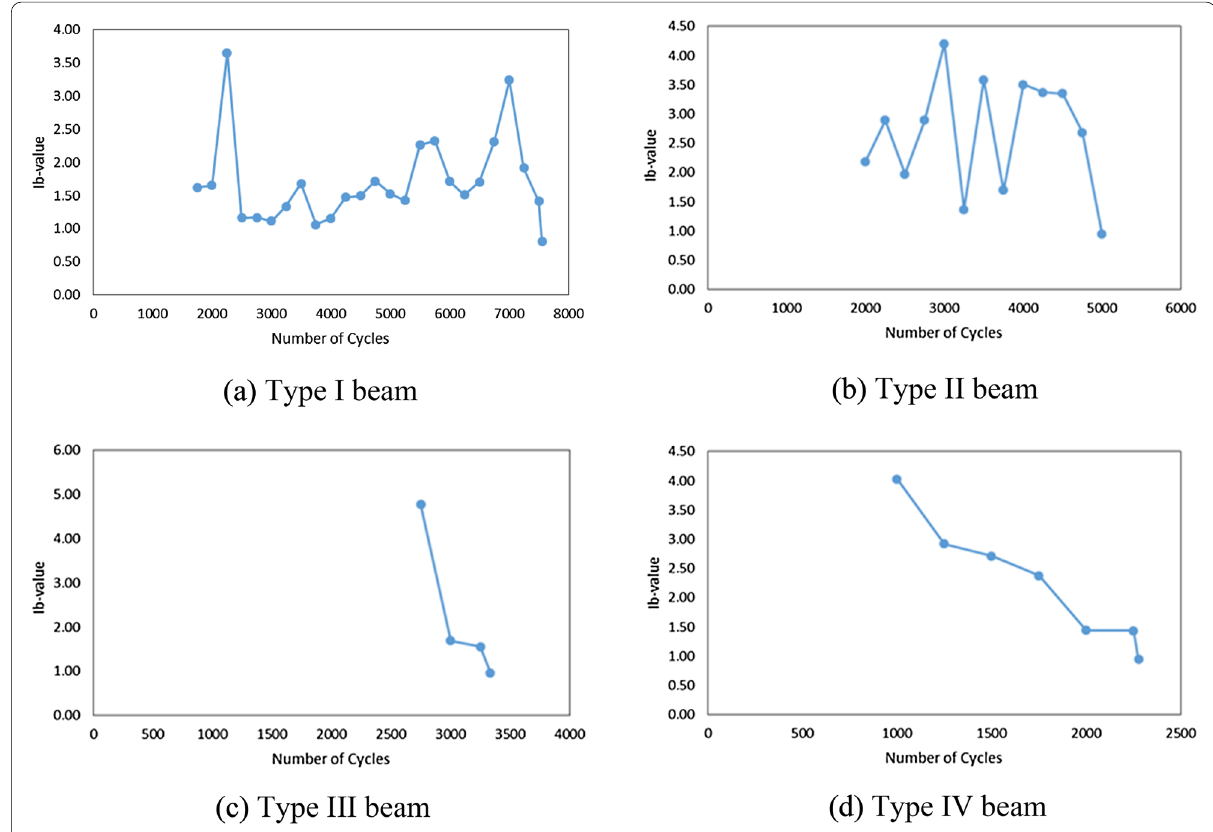
Fig. 8 The Ib-value versus the number of